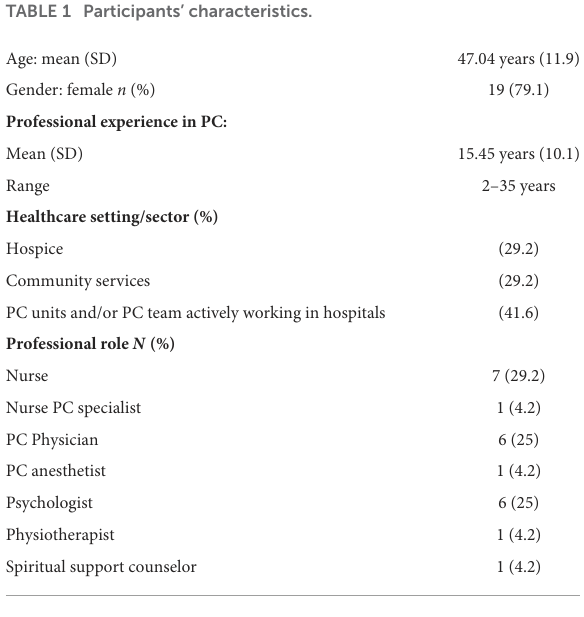
TABLE 1 Participants’